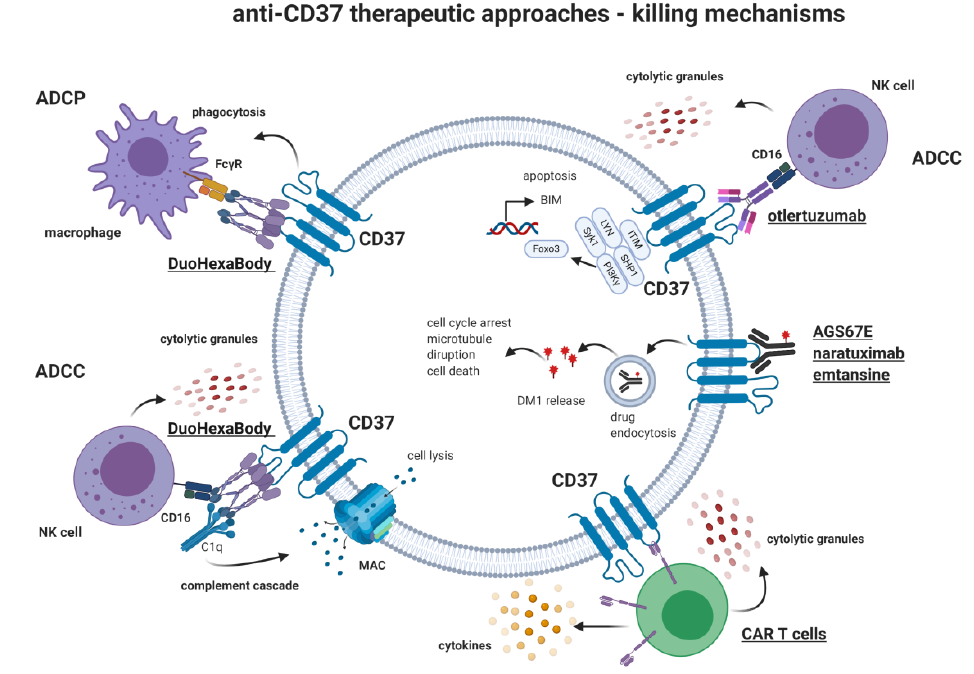
Figure 2. Anti-CD37 therapeutic approaches- killing mechanisms. Several therapeutics have been studied, including monoclonal antibodies (e.g., Otlertuzumab, DuoHexaBody), an antibody-drug conjugate (Naratuximab Emtansine), and chimeric antigen receptor T cells (CAR-T). Different tumor cell killing mechanisms were exploited, e.g., complement-dependent cellular cytotoxicity (CDCC), antibody-dependent cellular phagocytosis (ADCP), antibody-dependent cellular cytotoxicity (ADCC), and direct induction of apoptosis. ITIM: immune tyrosine-based inhibitory motif; MAC: membrane attacking complex; C1q: complement component 1q; FcγR: Fc-gamma receptor; FOXO3: Forkhead box O3.